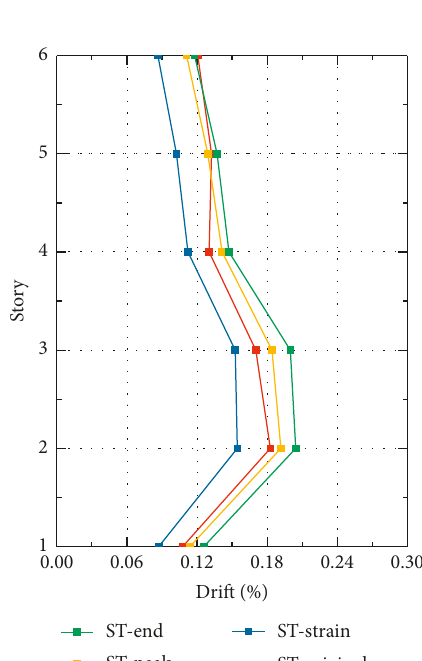
Figure 10: Story